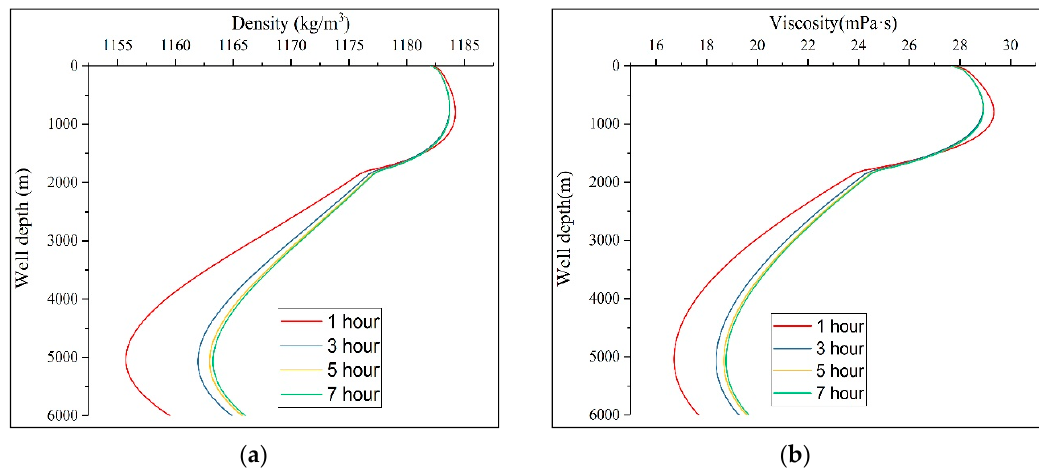
Figure 12. Variation of density and viscosity with time during normal circulation. ( a ) Drilling fluid density changes over time; ( b ) Drilling fluid viscosity changes over